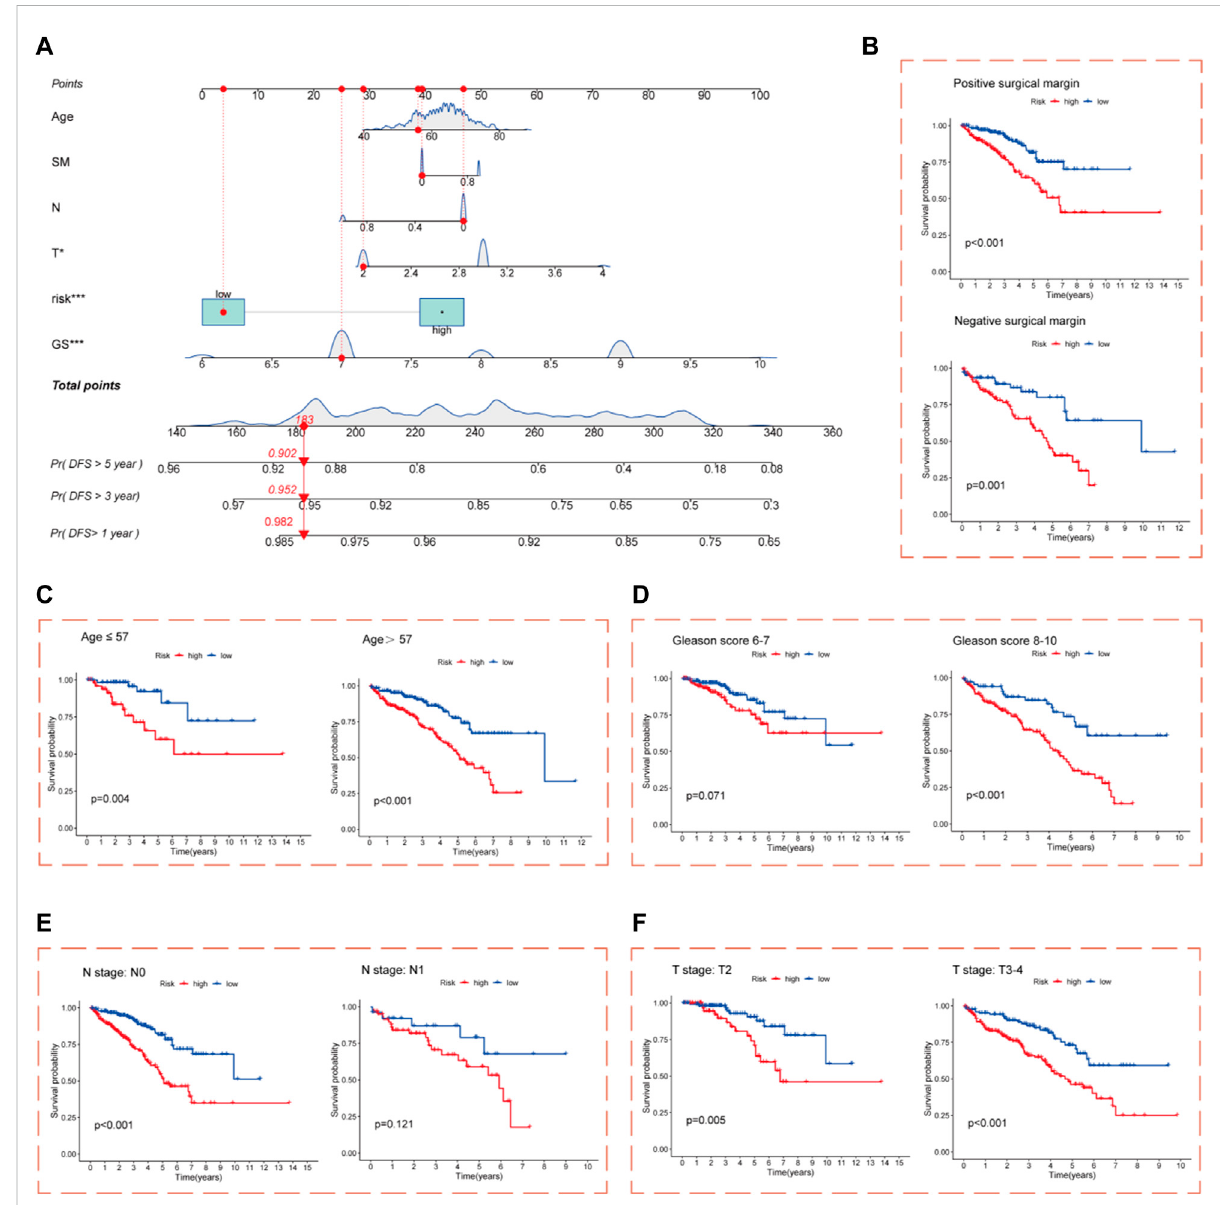
FIGURE 4 Construction of nomograms. (A) Nomograms composed of clinicopathological characteristics and risk score to predict 1-, 3-, and 5-year DFS of PCa patients; Kaplan – Meier survival curves for the high- and low-risk cohort based on clinicopathological variables are shown (B) Positive and negative SM subgroups. (C) Age (57 years and ≤ 57 years) subgroups. (D) GS (6 – 7 and 8 – 10) subgroups. (E) Pathological N0 and N1 stage subgroups. (F) Pathological T2 and T3 – 4 stage